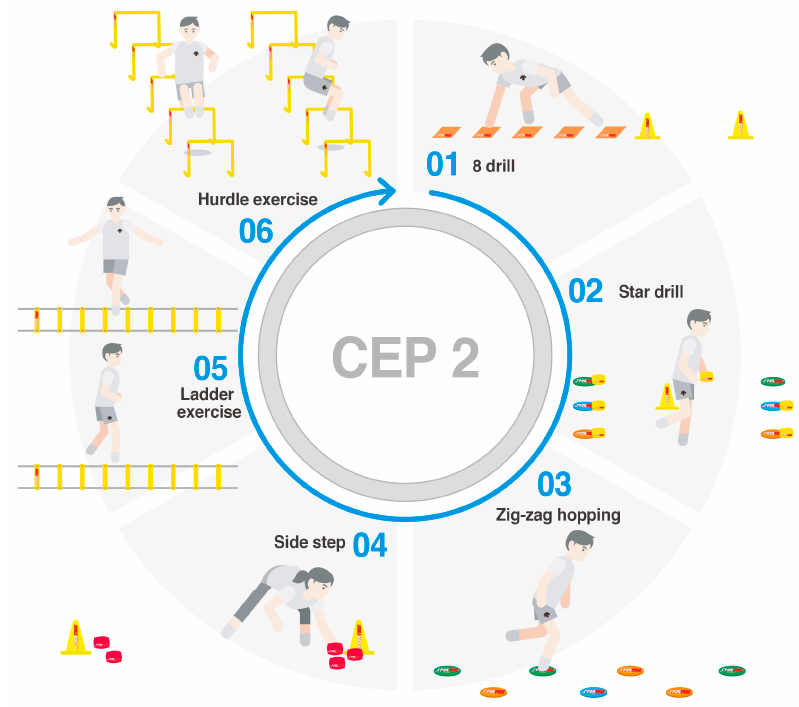
Figure A2. The sequence of motions for circuit exercise program 2: (1) 8 drill, (2) Star drill, (3) Zig-zag hopping, (4) Side step, (5) Ladder exercise, (6) Hurdle exercise.